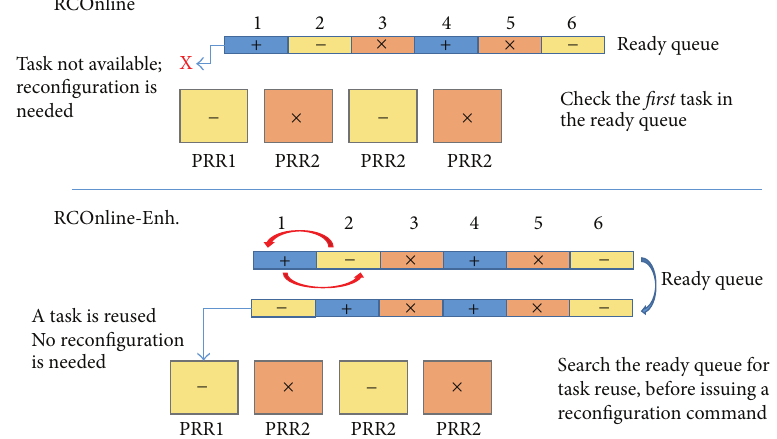
Figure 7: RCOnline versus RCOnline-Enh.